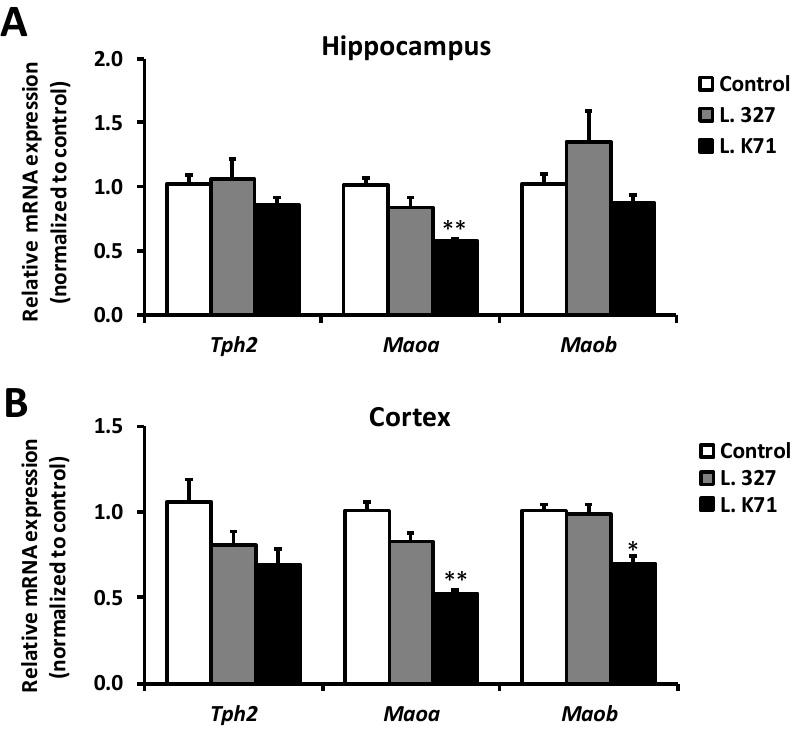
Figure 4. Expression of serotonin synthesis and degradation enzymes in the hippocampus ( A ) and cortex ( B ) of SAMP8 fed for 43 weeks diets containing Lactobacillus strains. Data are expressed as mean ± SEM; n = 8 mice per group; * p < 0.05, ** p < 0.01 vs. the control group. Tph2 , tryptophan hydroxylase 2; Maoa , monoamine oxygenase A; Maob , monoamine oxygenase B.